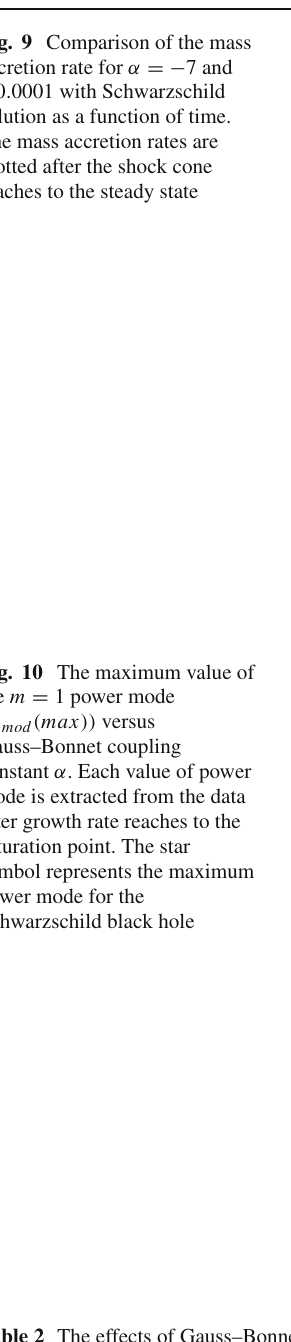
Table 2 The effects of Gauss–Bonnet coupling constant α to the accretion mechanism, shock cones, and physical interpretation are summarized. D represents decreasing while I represents increasing. SS , SC , PD stand for Steady State, Shock Cone, and Power Mode, respectively Time to reach the